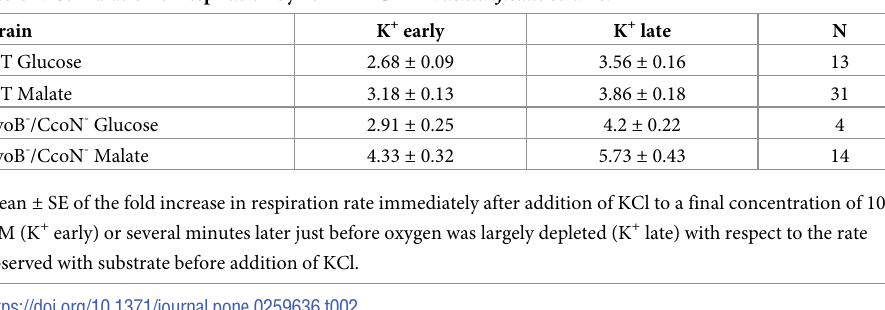
Table 2. Stimulation of respiration by 10 mM KCl in P . denitrificans strains. Strain K + early WT Glucose